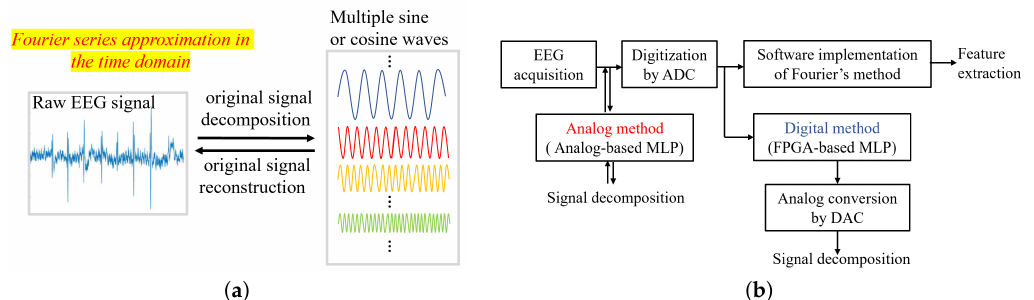
Figure 1. Comparison between the analog method and digital method aimed at electroencephalogram (EEG) signal processing with machine learning mechanism. ( a ) EEG signal decomposition/reconstruction by using fourier series approximation. ( b ) The analog-based multi-layer perceptron (MLP) and field programmable gate array (FPGA)-based MLP in the handling of the EEG